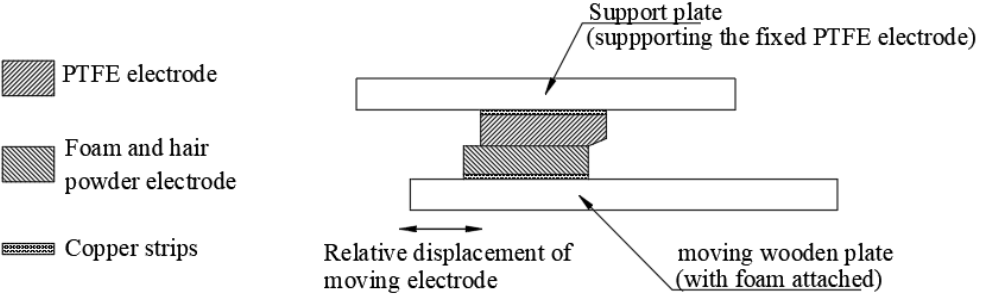
Figure 6. Prototype TENG constructional details.